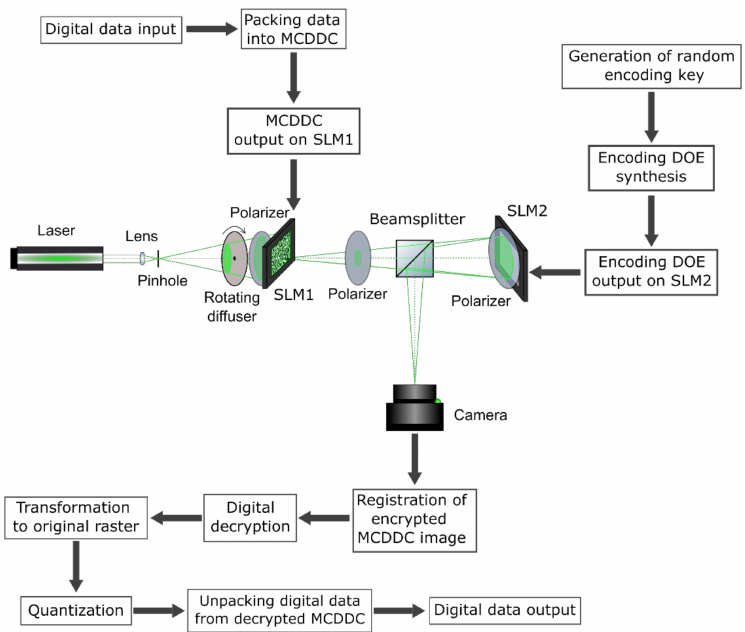
Figure 7. The experimental scheme of MCDDC lensless optical encryption with spatially incoherent